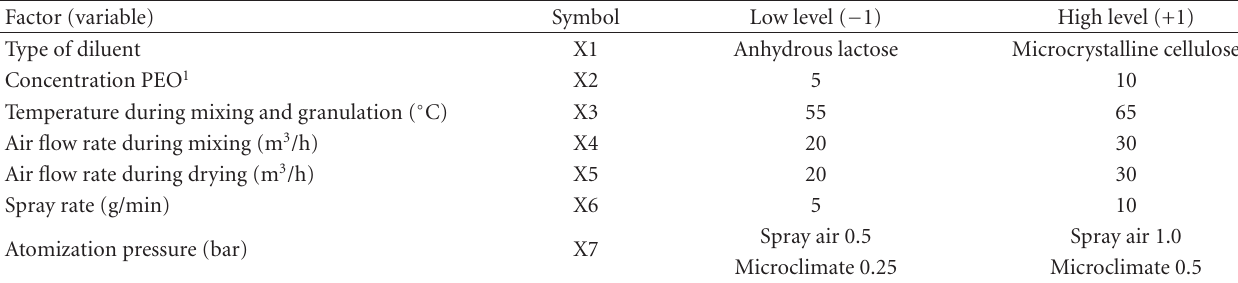
Table 1: Dependent variables in the first set of experiments.